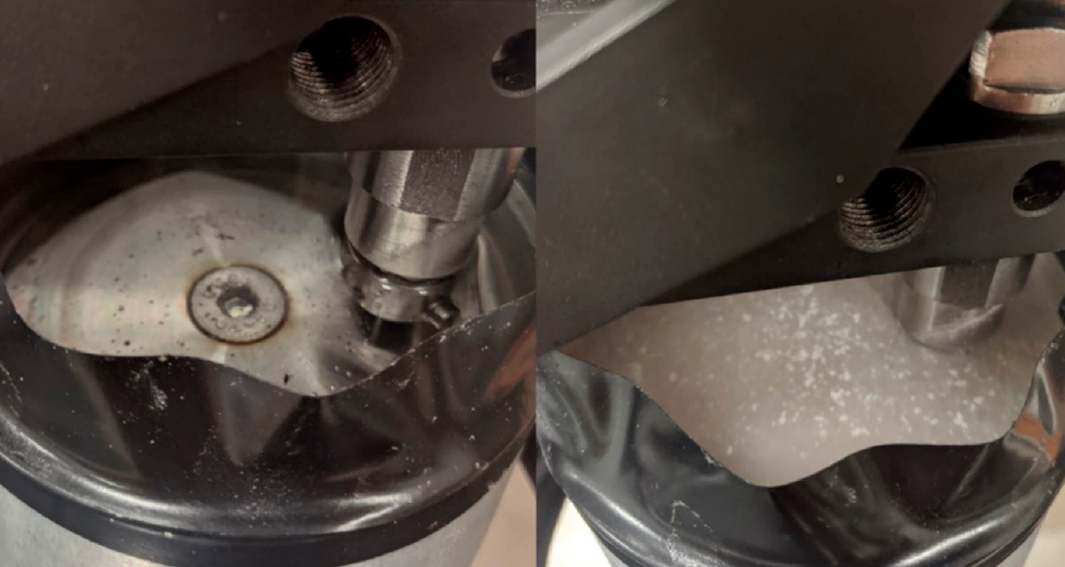
Figure 19. ( Left ) Water contamination with wear products after examination of the fibrous composite and ( right ) the unreinforced ABS polymer.